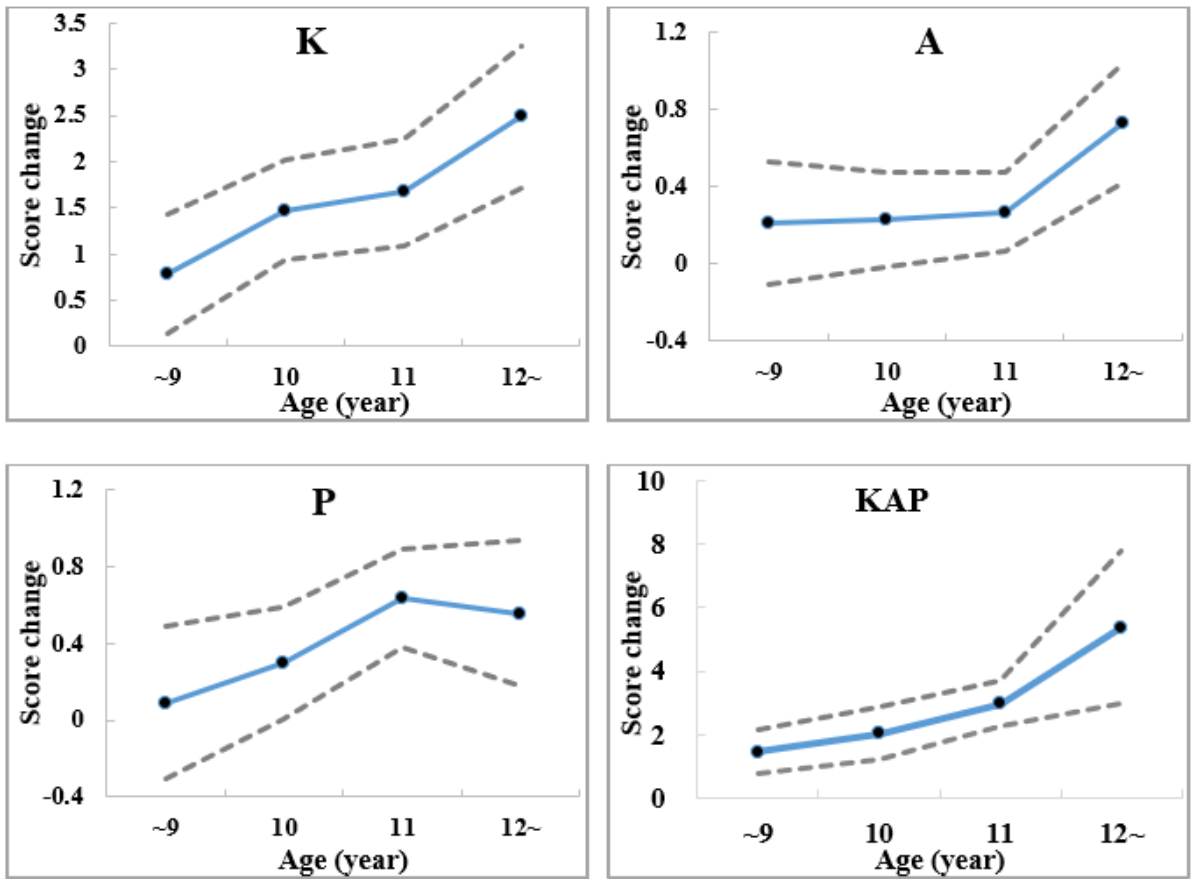
Figure 2. Age-specific KAP score changes after intervention for students in the intervention school compared with the control school (adjusted with sex by difference − in − difference (DID) analysis; the dotted lines represent the upper and lower limit of the 95% Confidence Interval of the score change; KAP represents the total score of knowledge, attitude, and practice; K: knowledge; A: attitude; P: practice; score changes mean DID estimators).